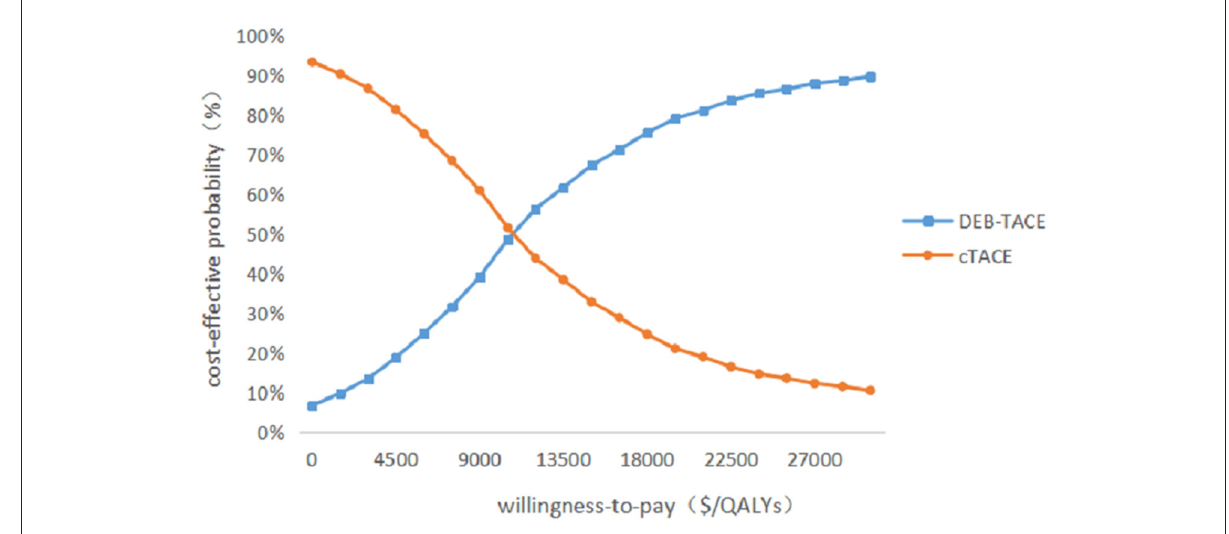
FIGURE6 Cost-effectiveness acceptability